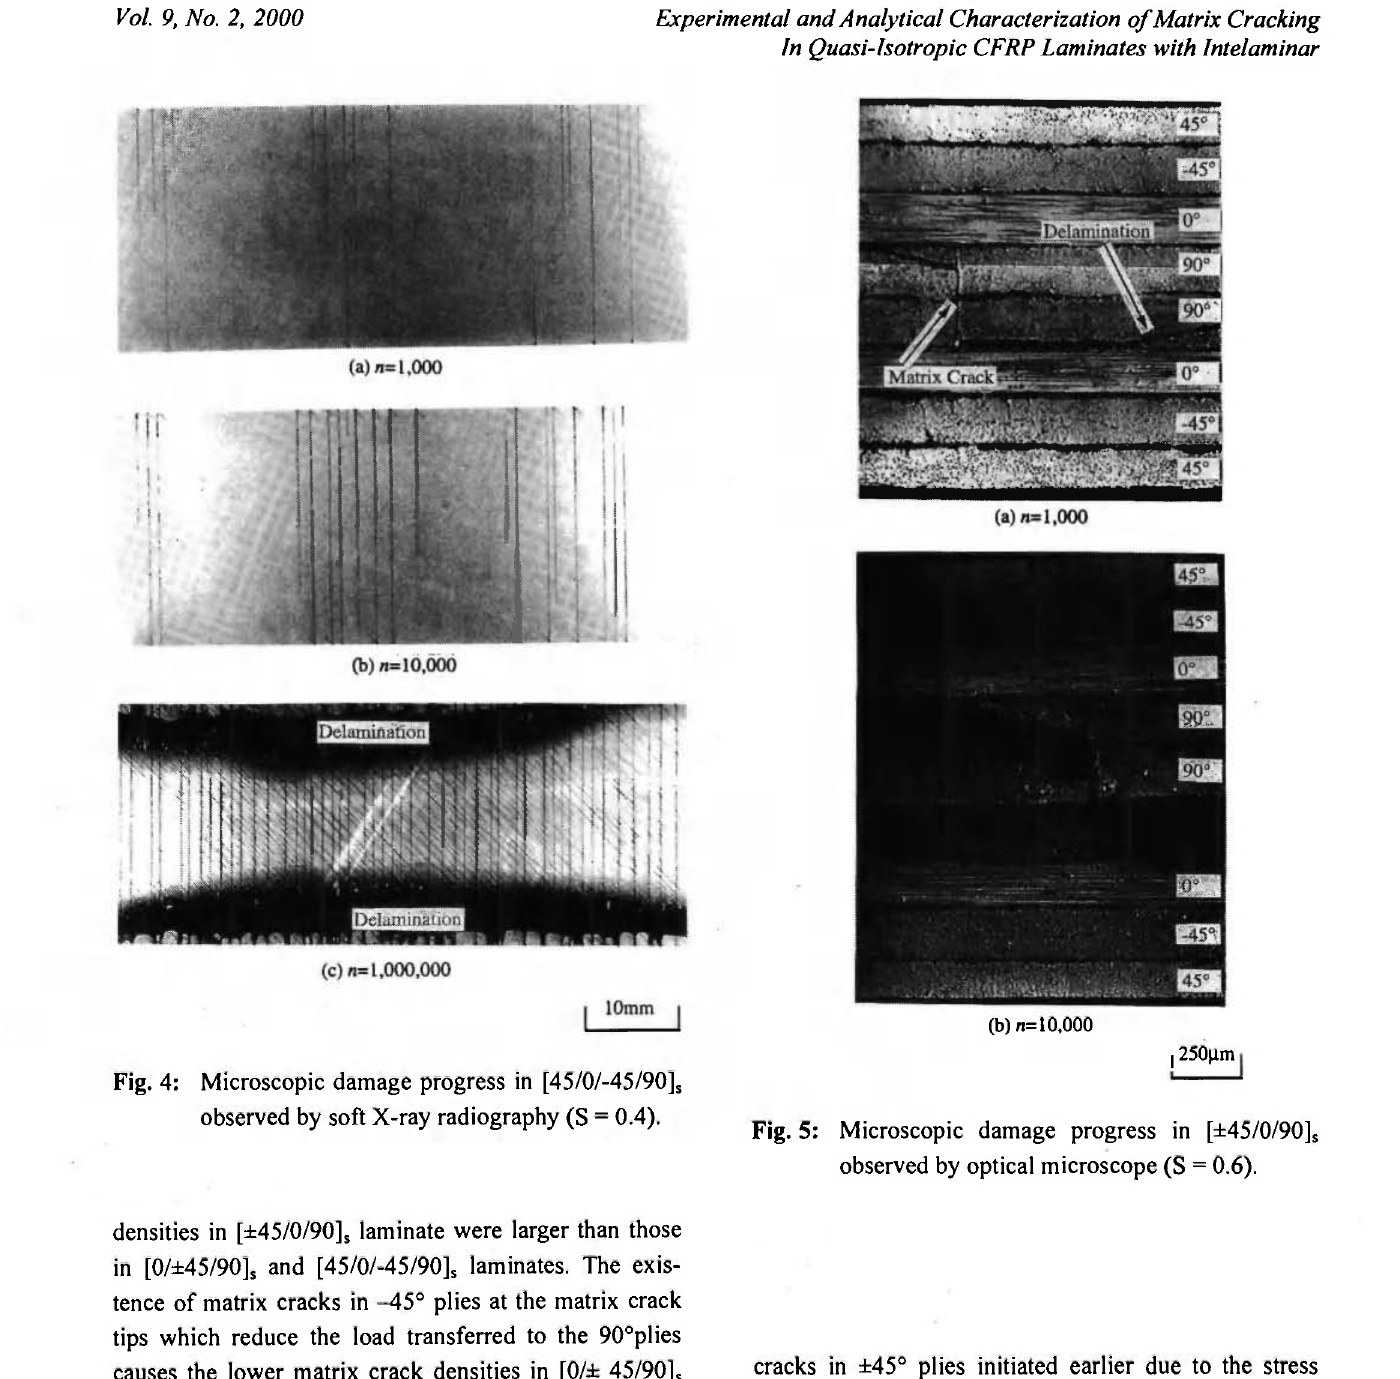
cracks in ±45° plies initiated earlier due to the stress concentration at the matrix crack tip. Matrix crack den- sity in 45° plies was much lower than that in -45° plies. Figure 9 shows the relation between delamination ratio and number of cycles. In [± 45/0/90] s laminate, the number of cycles when delamination growth is saturated corresponded to the cycles when matrix crack initiates in ±45° plies. Furthermore, matrix crack density growth rate in 90° plies became small at those cycles. This is be- cause 90° plies carry little load in the delamination